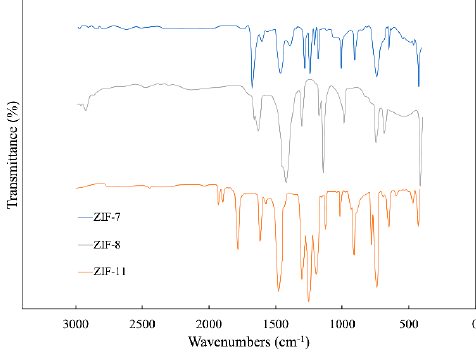
Figure 2. FTIR spectra of ZIF-7, ZIF-8 and ZIF-11.